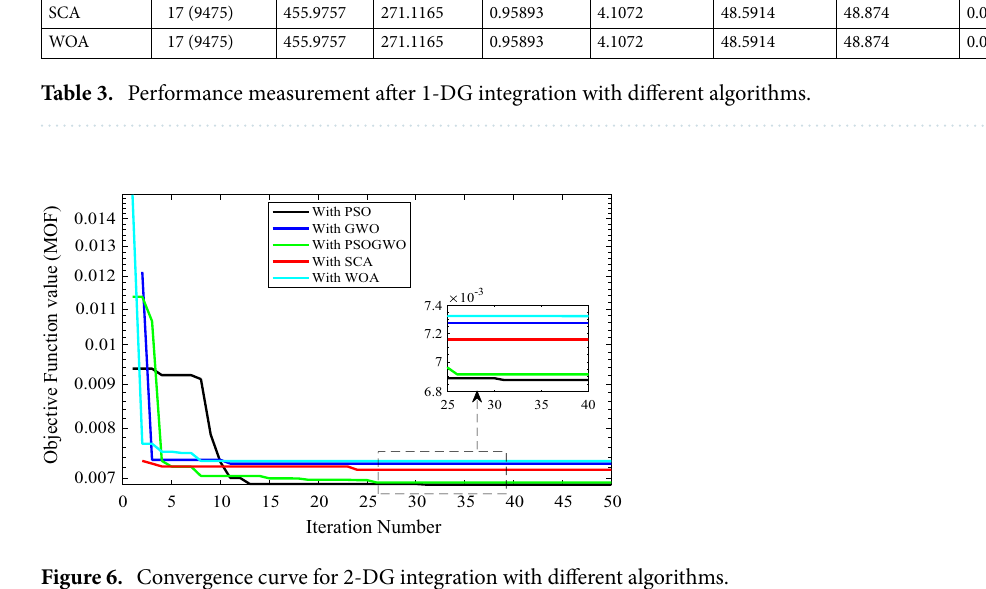
Figure 6. Convergence curve for 2-DG integration with different